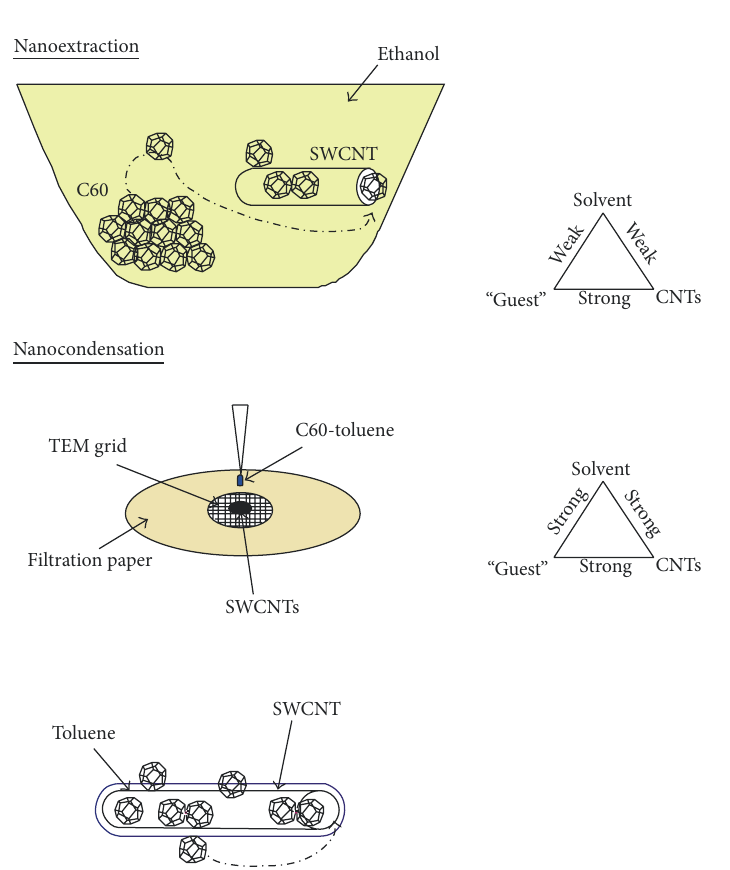
Figure 5: Scheme of the nanoextraction and nanocondensation processes (the figure is based on [133]).